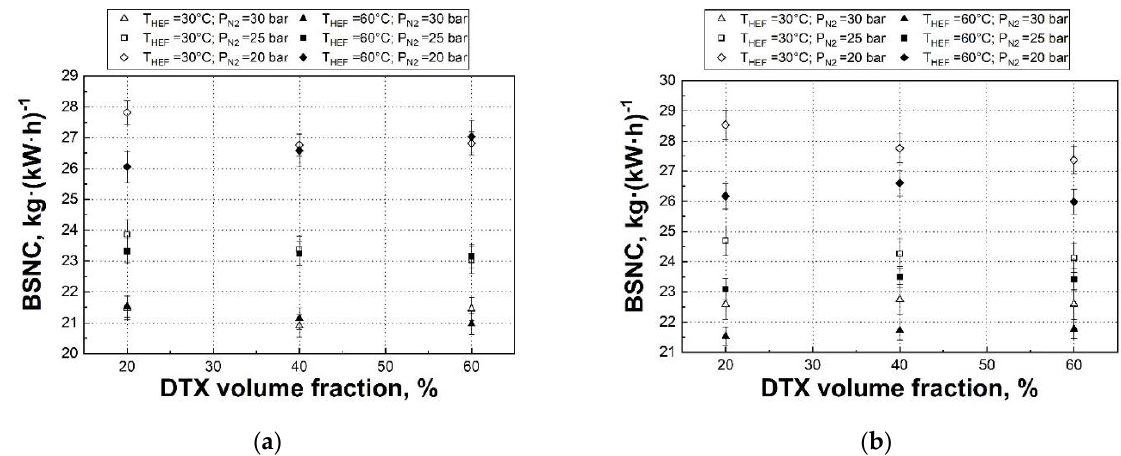
Figure 12. Brake specific nitrogen consumptions (BSNCs) at different operation conditions: ( a ) N = 600 rpm and ( b ) N = 700 rpm.